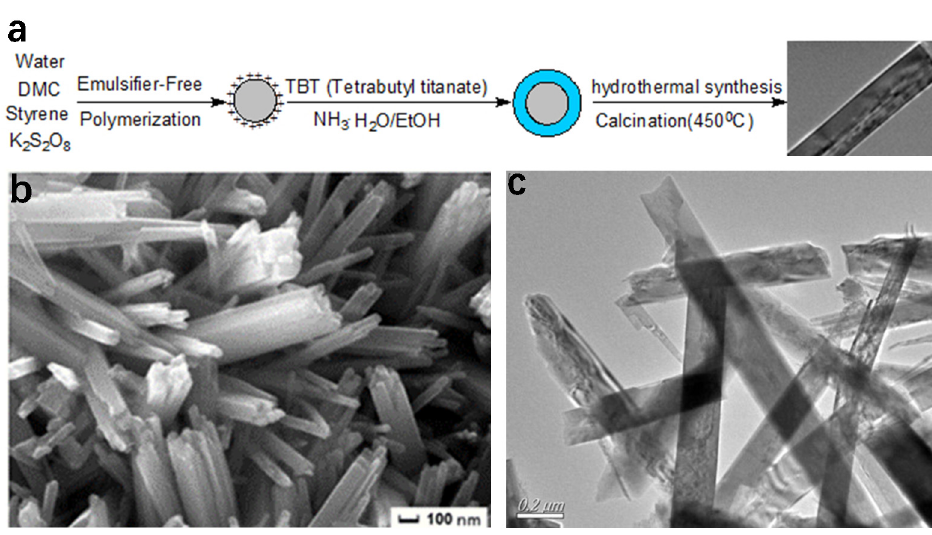
Figure 3. The demonstration ( a ), SEM ( b ), and TEM ( c ) of the C-TiO 2 single crystal nanorod. Reprinted with permission from Ref. [8].